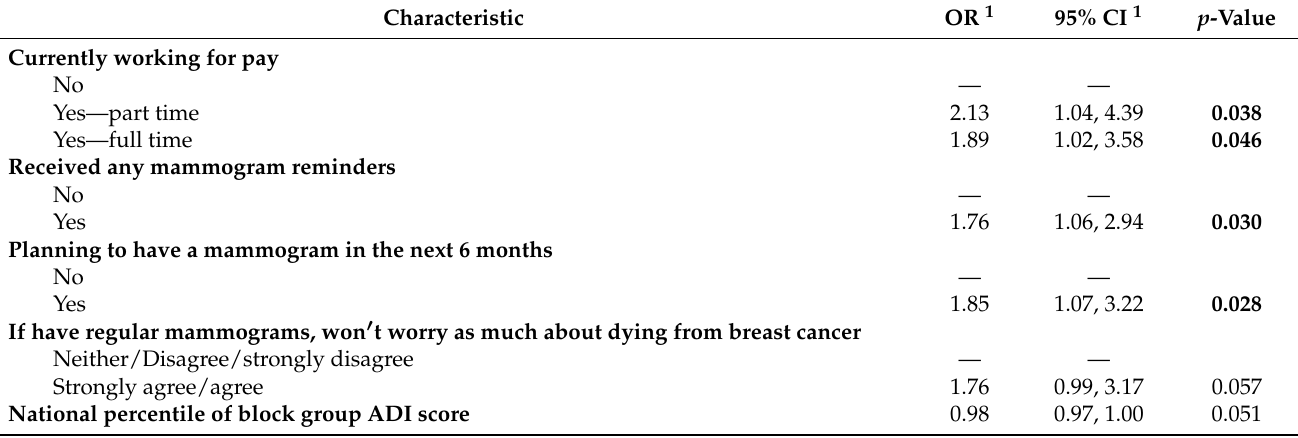
Table 3. Cont . Characteristic OR 1 95% CI 1 p